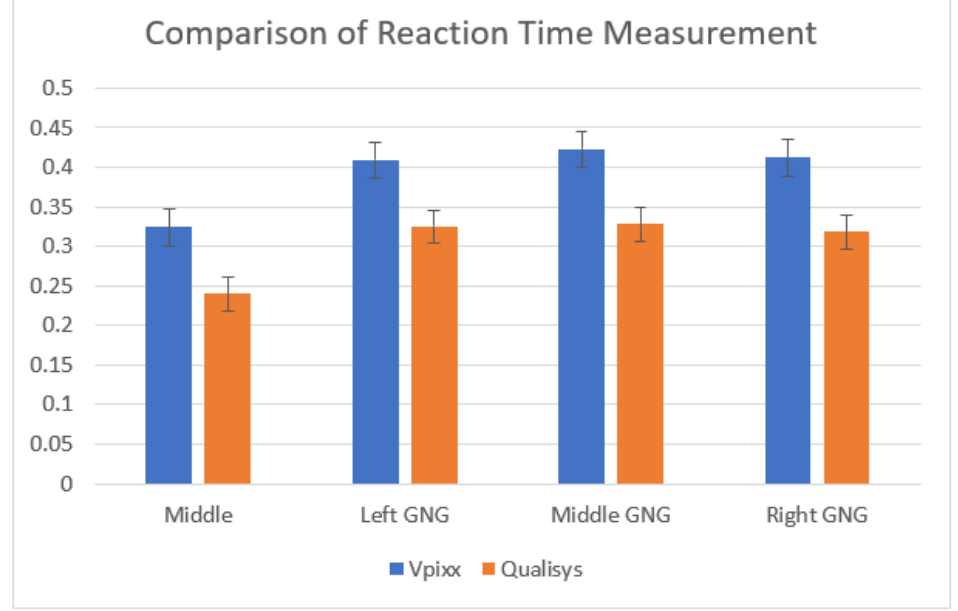
Figure 5. Means and standard errors of Qualisys- and VPixx-defined RTs for middle practice and each Go/No-Go task.